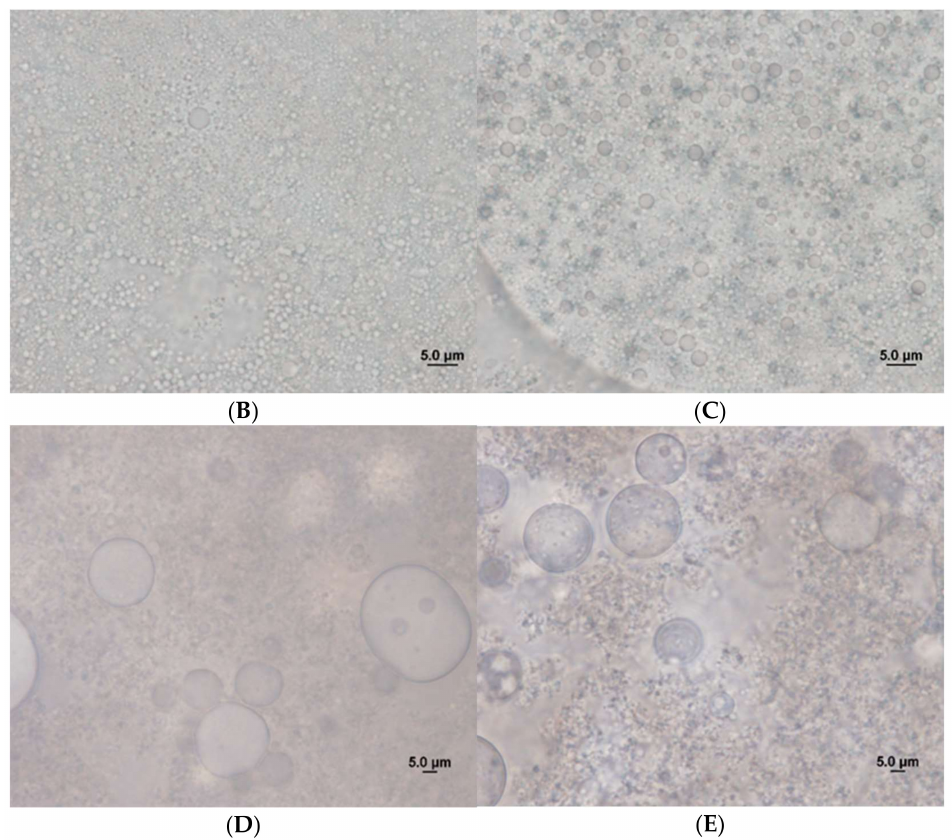
Figure 6. Micrographs corresponding to the different processed types of fresh yoghurt: control yoghurt ( A ); yoghurt with emulsion without RSV 30/70 ( B ); yoghurt with emulsion without RSV 20/80 ( C ); yoghurt with emulsion with RSV 30/70 ( D ); yoghurt with emulsion with RSV 20/80 ( E